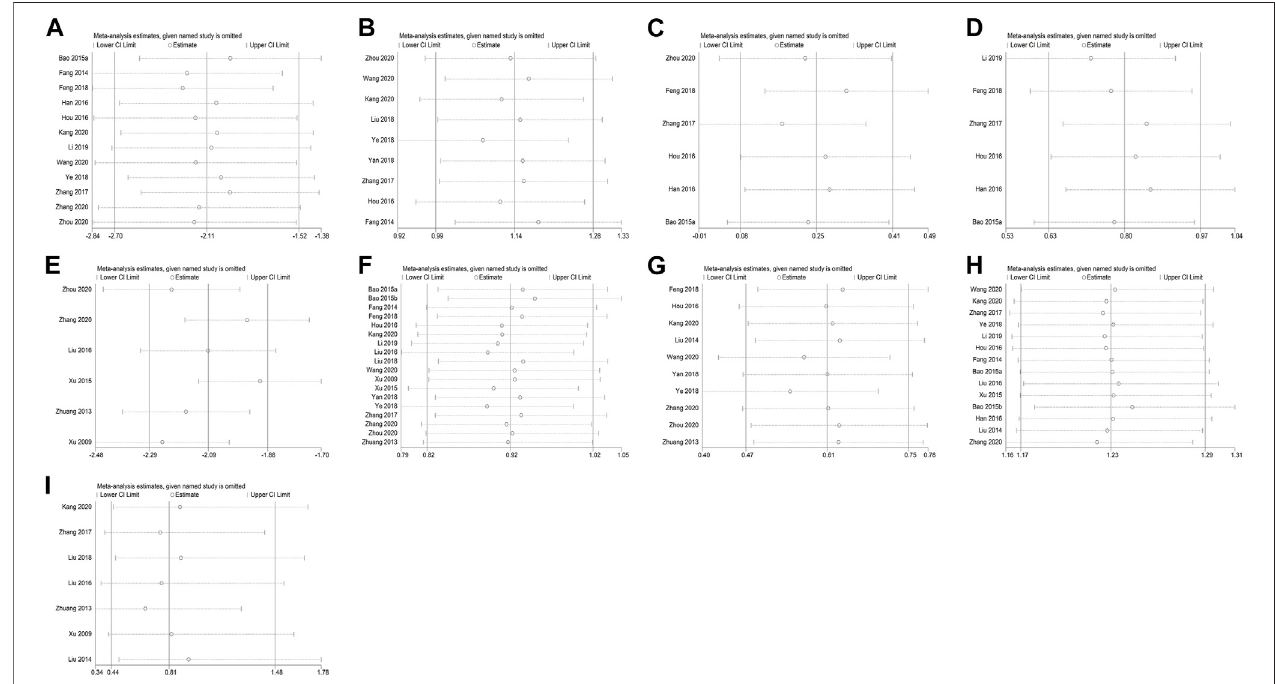
FIGURE9| SensitivityanalysisforALP (A) ,BGP (B) ,S-Ca (C) ,S-P (D) ,VAS (E) ,BMDatlumbarspine (F) ,BMDatfemoralneck (G) ,effectiverate (H) ,andADR (I) .